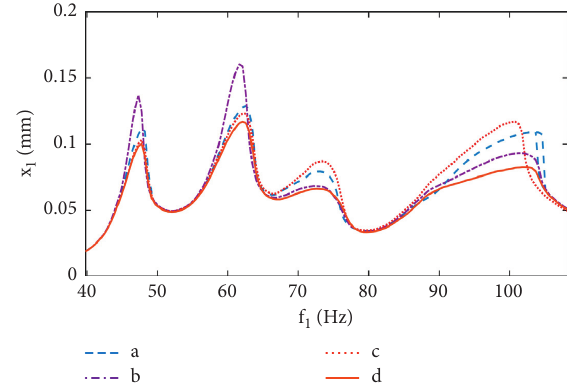
Figure 18: Comparisons of effects of vibration suppression with different SFD configurations (a: two supports of the low-pressure shaft, b: front support of low-pressure shaft and front support of high-pressure shaft, c: rear support of low-pressure shaft and front support of high-pressure shaft, d: all three supports.).